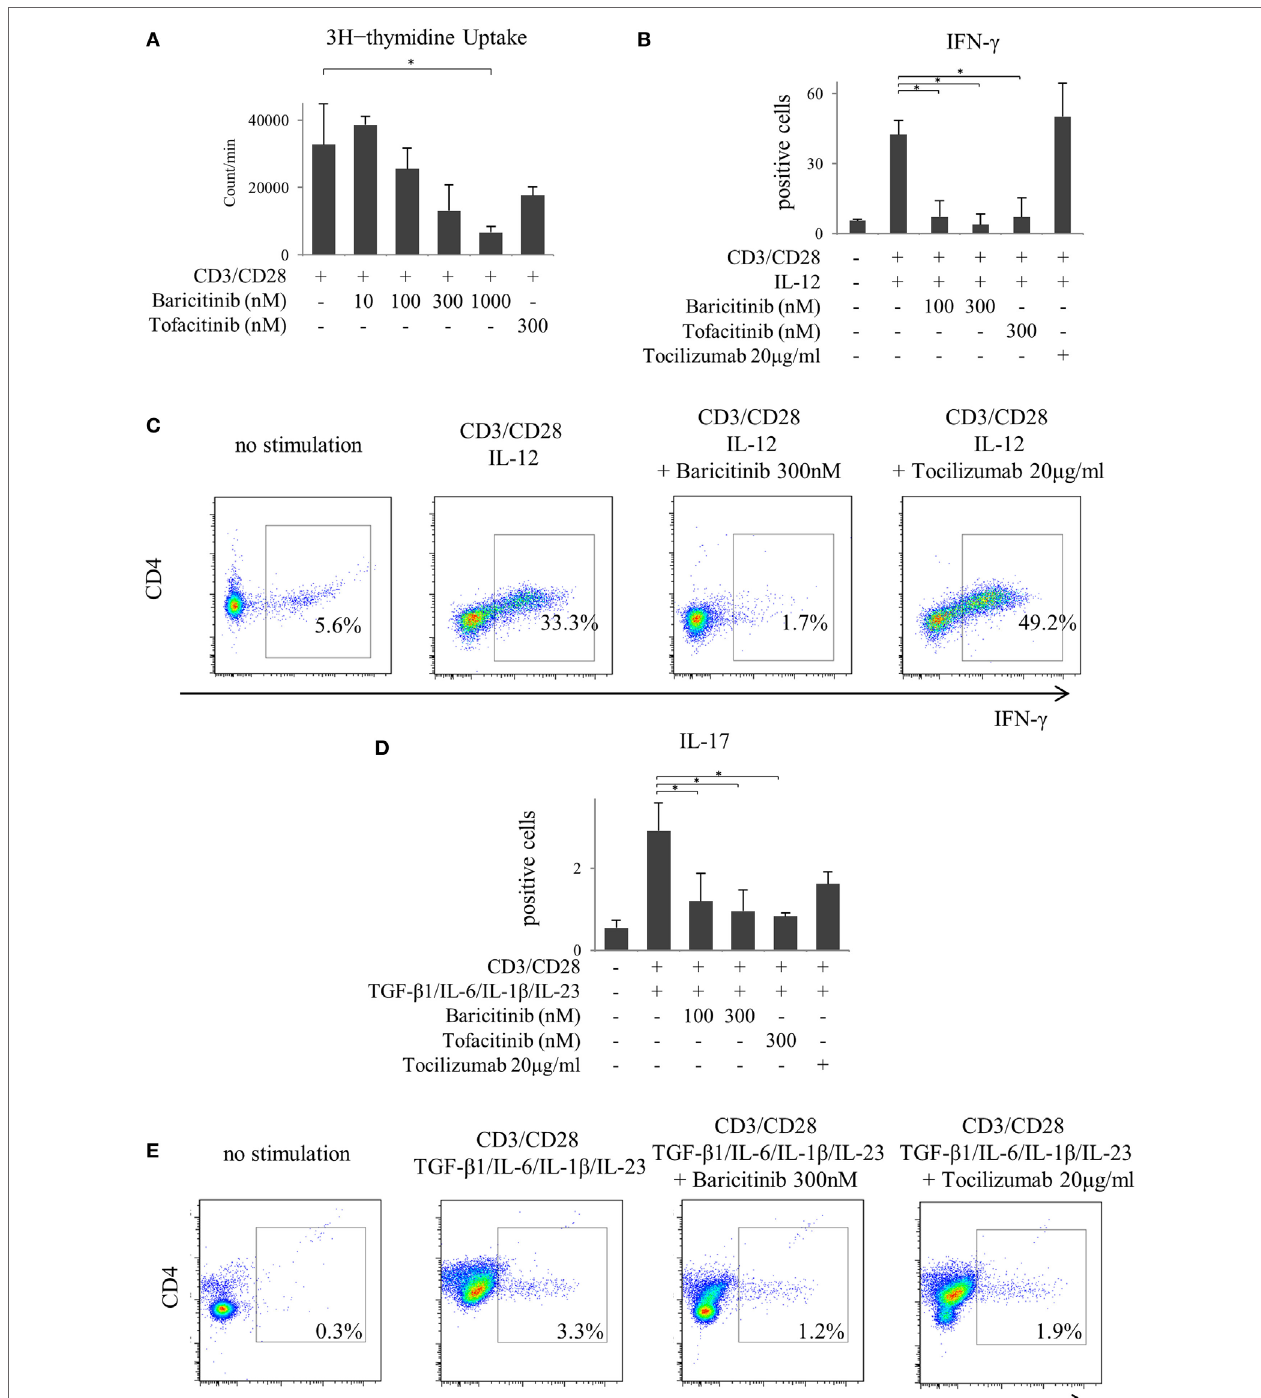
FigUre 5 | Baricitinib inhibits T cell proliferation and differentiation of Th1 and Th17 cells. Human naive CD4 + T cells were purified and cultured with anti-CD3 antibody, anti-CD28 antibody, and various cytokines [interleukin (IL)-12, TGF- β , IL-6, IL-1 β , and IL-23]. (a) T cell proliferation assessed by [ 3 H] thymidine incorporation. (B) Percentage of interferon (IFN)- γ -producing cells in T cells in the presence of baricitinib and other inhibitors. (c) Representative flow cytometry plots showing IFN- γ production in T cells. (D) Percentage of IL-17-producing cells in T cells in the presence of baricitinib and other inhibitors. (e) Representative flow cytometry plots showing IL-17 production in T cells. Data are mean ± SD of three different donors per group. * p < 0.05 (by Mann–Whitney U